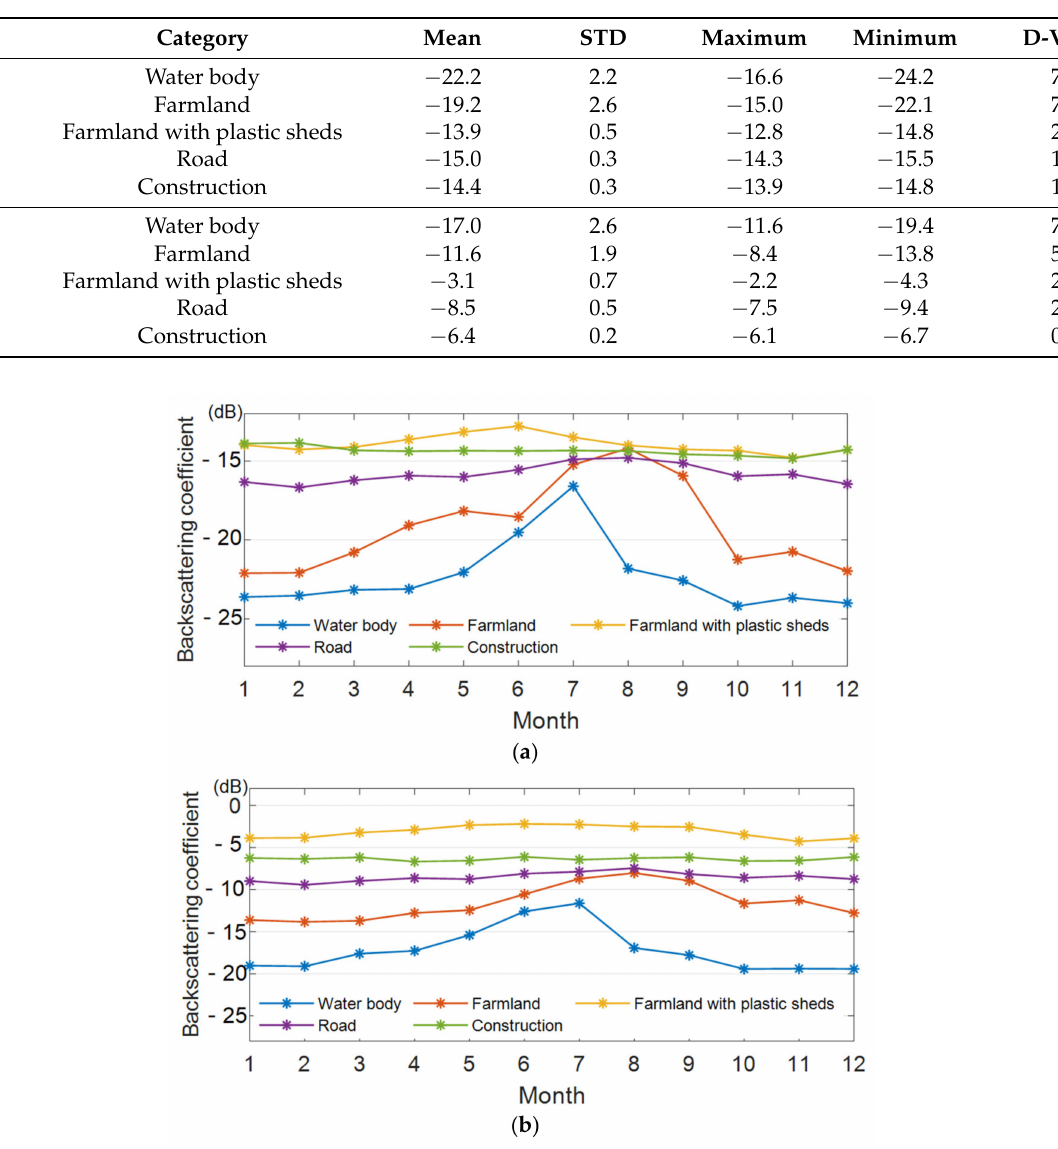
Table 2. Statistical backscattering coefficient with integrated orbit in 2019 (Unit: dB).